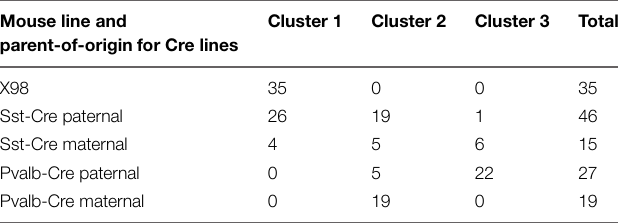
TABLE 2 | Mouse lines and parent-of-origin for Cre lines. Mouse line and parent-of-origin for Cre